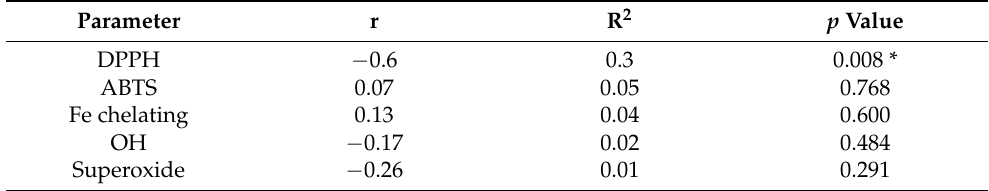
Table 5 represents linear model relating the number of paramagnetic centers (NPC) and antioxidant activity of HAs. There is only one significant linear correlation between DPPH and NPC, but this model could explain only 30% of total variance. For brevity, we omitted the full linear regression analysis of the dataset because this model is not relevant to the process being studied. Table 5. Linear correlations between antioxidant activity and the number of paramagnetic centers. Parameter